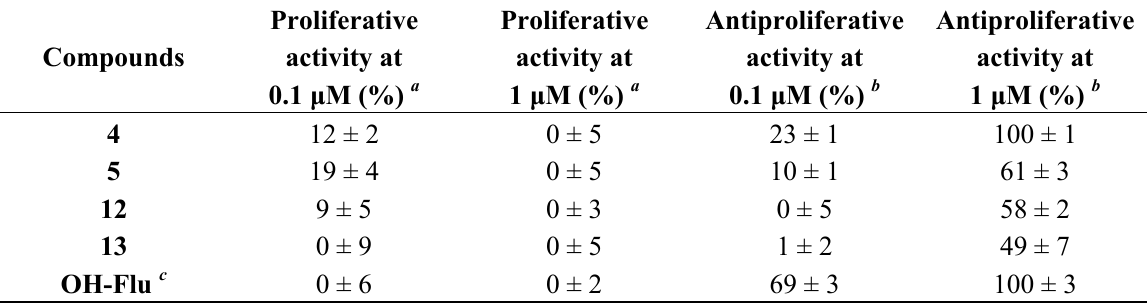
Table 2. Proliferative an antiproliferative activities of monospiro-compounds 4 , 5 , 12 and 13 on Shionogi (AR + )